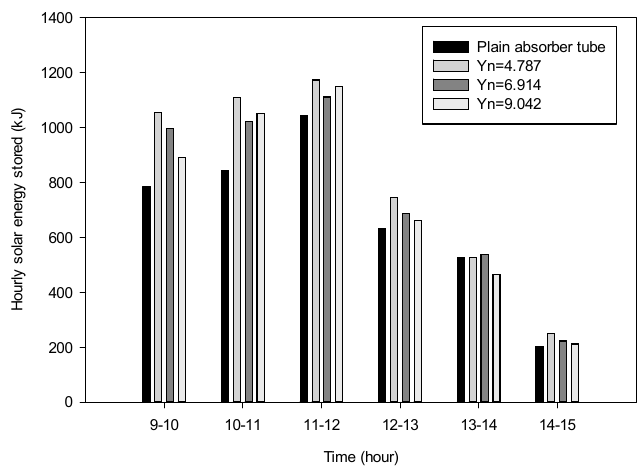
Figure 10. Variation in hourly solar energy stored with time and nail twist pitch ratio.